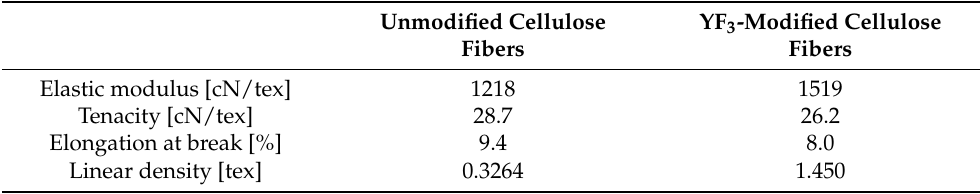
Table 1. Mechanical properties of the fibers.